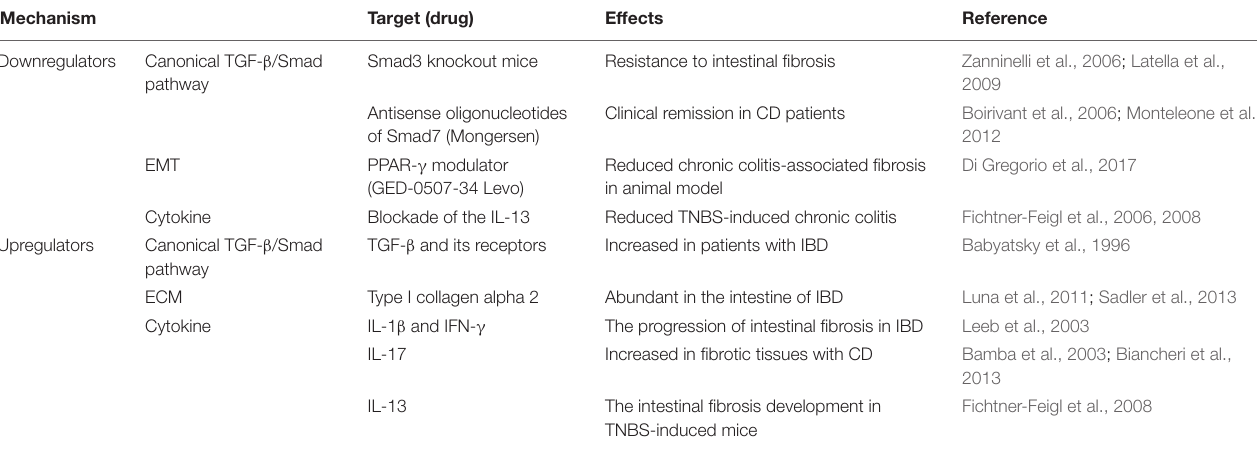
TABLE 2 | A summary of the regulators of TGF- β signaling pathway in intestinal